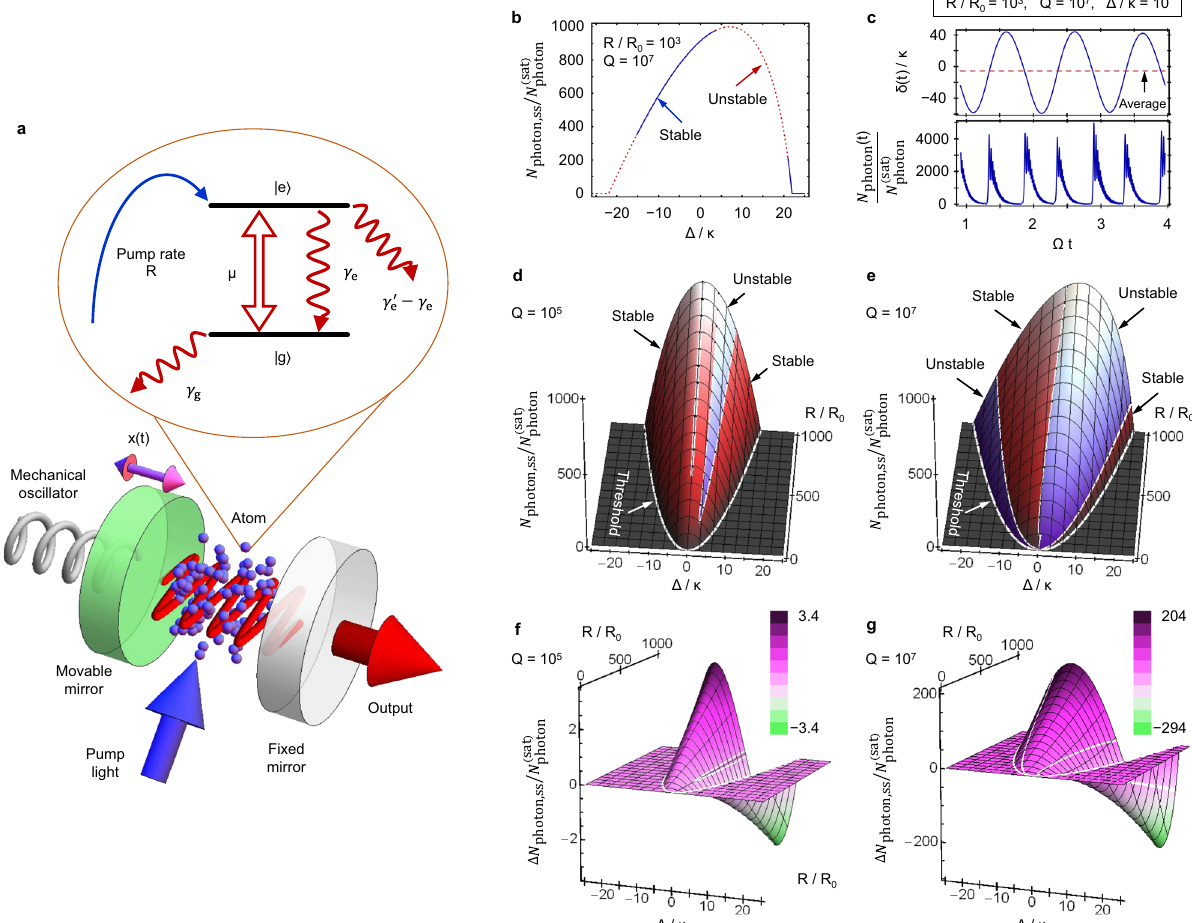
Fig. 1 Active optomechanics in the macroscopic limit. a Schematic of a generic cavity optomechanical system that operates in an active fashion. An ensemble of two-level (upper j e i and lower j g i ) atoms is coupled to an optical cavity with a single-photon coupling strength μ . A pump light excites the atoms onto j e i at a rate R . The total decay rate of j e i is γ 0 , wherein the decay rate of the atom from j g i to j e i is γ . The fast decay rate γ of j g i ensures the e g e population inversion between j e i and j g i . The active atoms emit photons into the optical cavity. The position of one cavity mirror is fi xed while the other mirror is movable. The motion of the movable mirror is modelled as a mechanical oscillator with a displacement x ð t Þ , oscillation frequency Ω , and damping rate Γ . The radiation pressure of the intracavity fi eld drives the mechanical oscillator. b Steady-state photon number N photon ; ss (in units of the saturation photon number N ð sat Þ ) as a function of the detuning Δ ¼ ω C (cid:2) ω A between the cavity mode frequency ω C and the atomic transition frequency ω A . The photon pump rate is set at R ¼ 10 3 R 0 with the minimum pump threshold R 0 and the cavity quality factor is Q ¼ 10 7 . The cavity loss rate κ ¼ ω C = Q is chosen as the frequency unit in the plot. The solid curves denote the stable steady-state solutions while the dashed lines correspond to the unstable steady-state solutions. c Time evolutions of the mechanical-displacement-induced detuning δ ð t Þ and the intracavity photon number N photon ð t Þ for the optomechanical system operating at an unstable steady state. The dashed line corresponds to the average value of δ ð t Þ . d , e Dependences of the steady-state N photon ; ss on the detuning Δ and the pump rate R for Q ¼ 10 5 and Q ¼ 10 7 , respectively. The boundaries of unstable steady-state regions have been plotted. The red shading denotes the stable steady states while the blue shading corresponds to the unstable steady states. f , g Photon differences Δ N photon ; ss between the active optomechanical system and the corresponding conventional laser for Q ¼ 10 5 and Q ¼ 10 7 , ffiffiffiffiffiffiffiffiffiffiffiffiffiffiffiffiffiffiffiffiffiffiffiffi p _ ω = 2 ε atoms are continuously pumped into the upper |e 〉 state at a rate V a ð t Þ with the C 0 eff R . The lasing action occurs for a large enough R . The radiation , reduced Planck ’ s constant _ , the vacuum electric permittivity ε 0 the effective volume V of the cavity mode, and the dimen- eff sionless amplitude a ð t Þ . Each atom is modelled as a two-level mirror leads to the parametric coupling between optical and system, i.e. upper |e 〉 and lower |g 〉 states, with a transition fre- ð t Þ ¼ mechanical degrees of freedom of the cavity. Here, N photon quency ω . The cavity mode frequency ω is close to ω with a A C A j a ð t Þj 2 accounts for the intracavity photon number. (cid:2) ω detuning Δ ¼ ω . The total decay rate of |e 〉 is γ 0 , wherein C A e . The decay the amount corresponding to the |g 〉 -|e 〉 branch is γ e of |g 〉 should be larger than γ for achieving the population rate γ g e inversion. The decay rate of the atomic polarization is then given ¼ ð γ þ γ Þ = 2. The coupling strength between the optical by γ ffiffiffiffiffiffiffiffiffiffiffiffiffiffiffiffiffiffiffiffiffiffiffiffi p eg e g = 2 ε _ V ω cavity and the atomic |g 〉 -|e 〉 transition is μ ¼ d C 0 eff with the associated electric dipole moment d of the atom. The